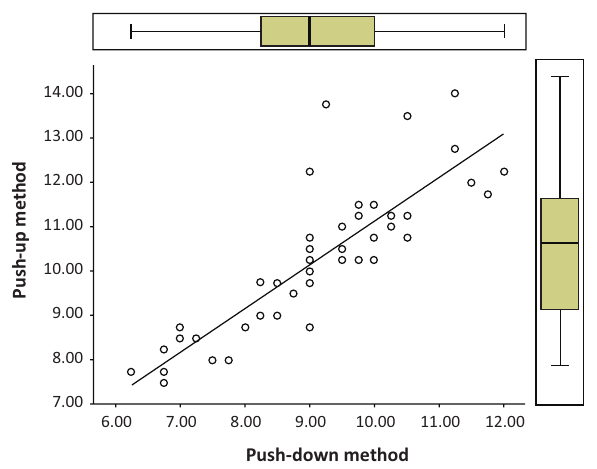
FIGURE 2: Scatter plot of push-down against push-up techniques, with the line of equality indicated. The regression equation is expressed as follows: push- down = 1.62 + 0.73 (push-up). Correlation coefficient between the two methods was r = 0.85 ( p = 0.00).